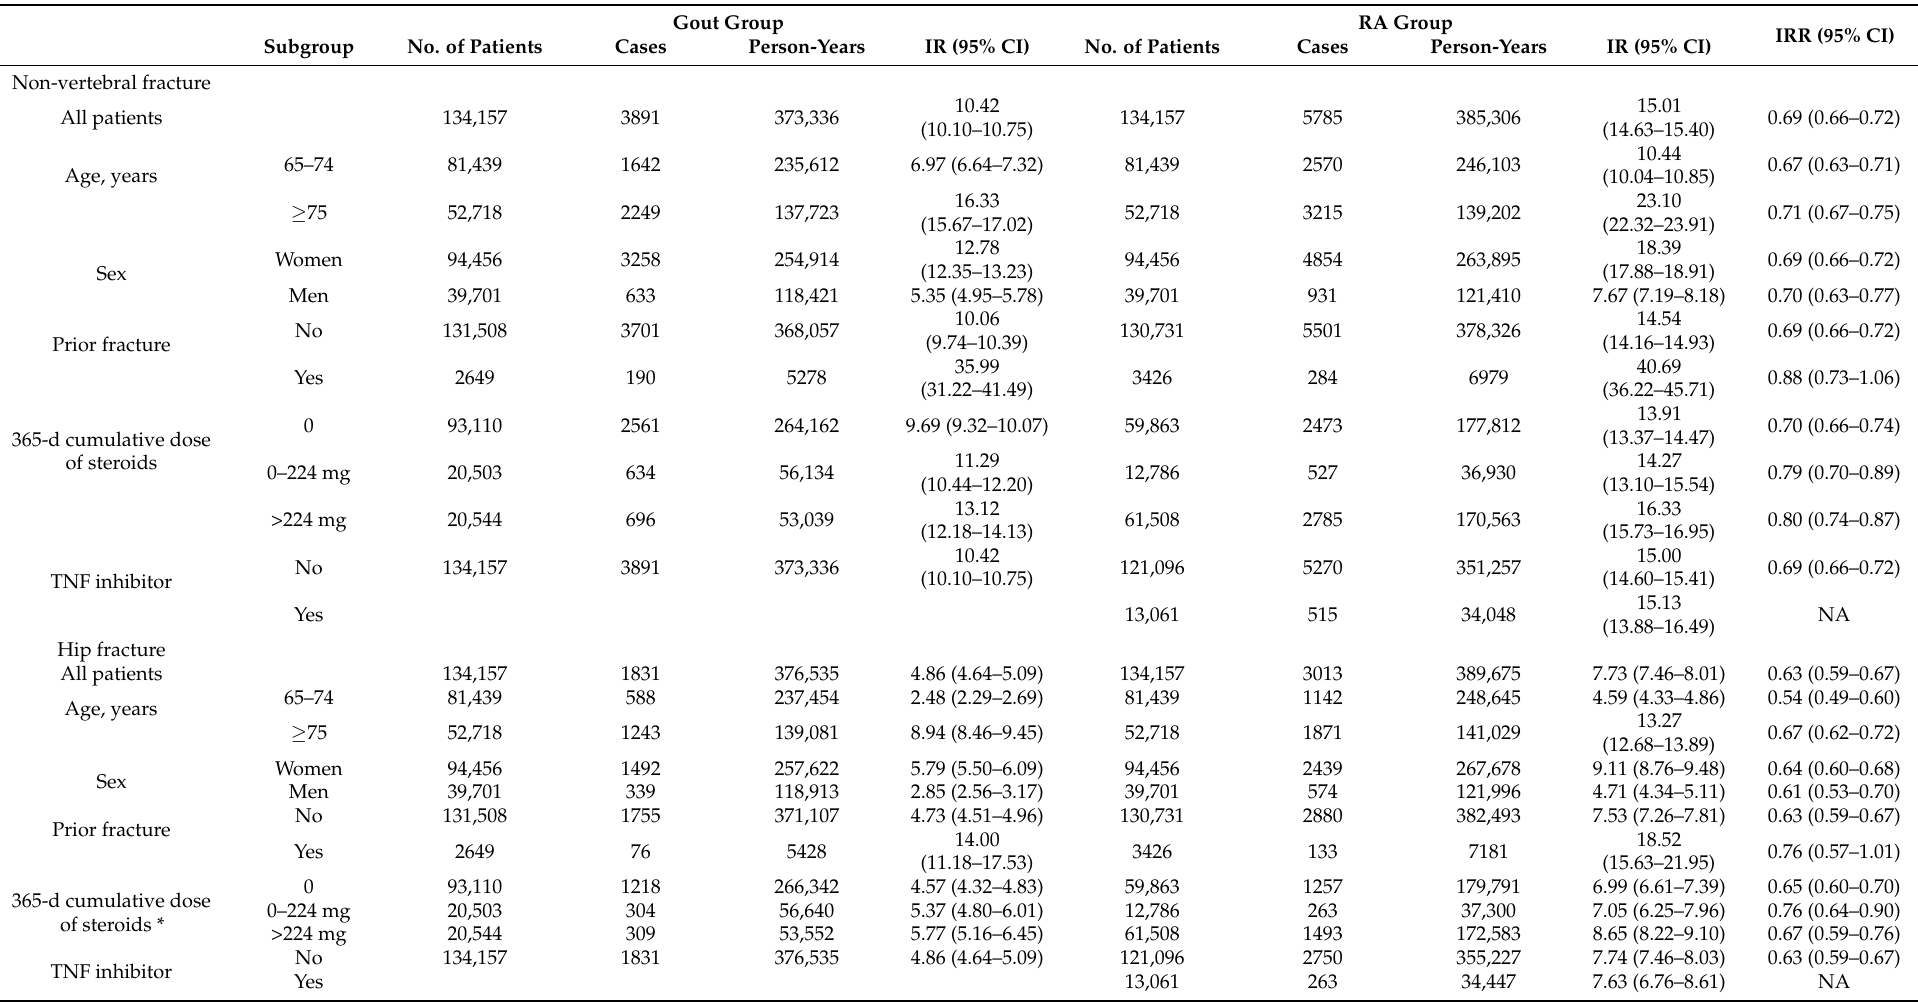
Table 2. Incidence rates and incidence rate ratio of fracture per 1000 person-year in the gout group versus RA group: age, sex, and index date